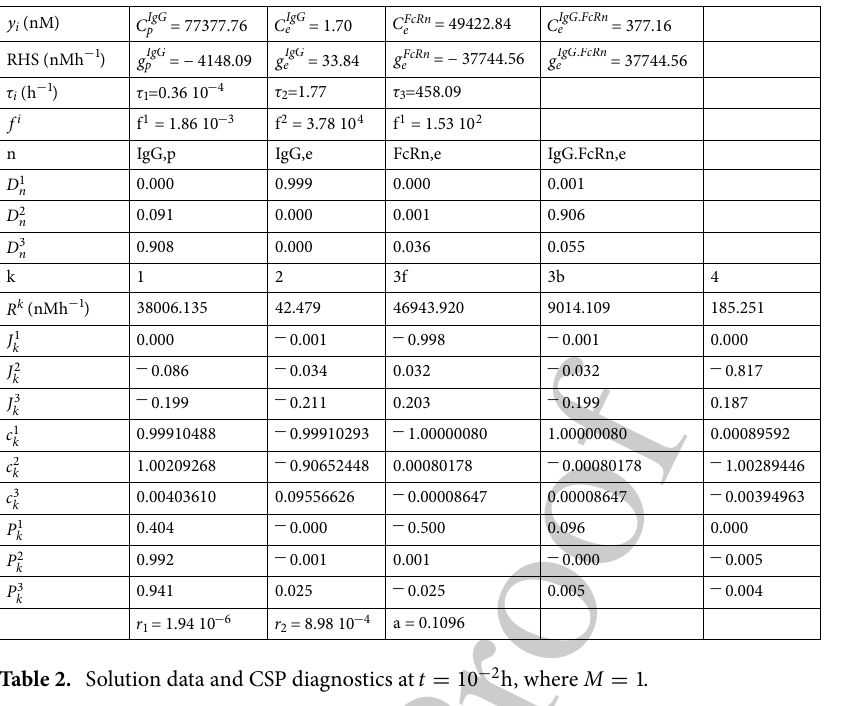
Table 2. Solution data and CSP diagnostics at t = 10